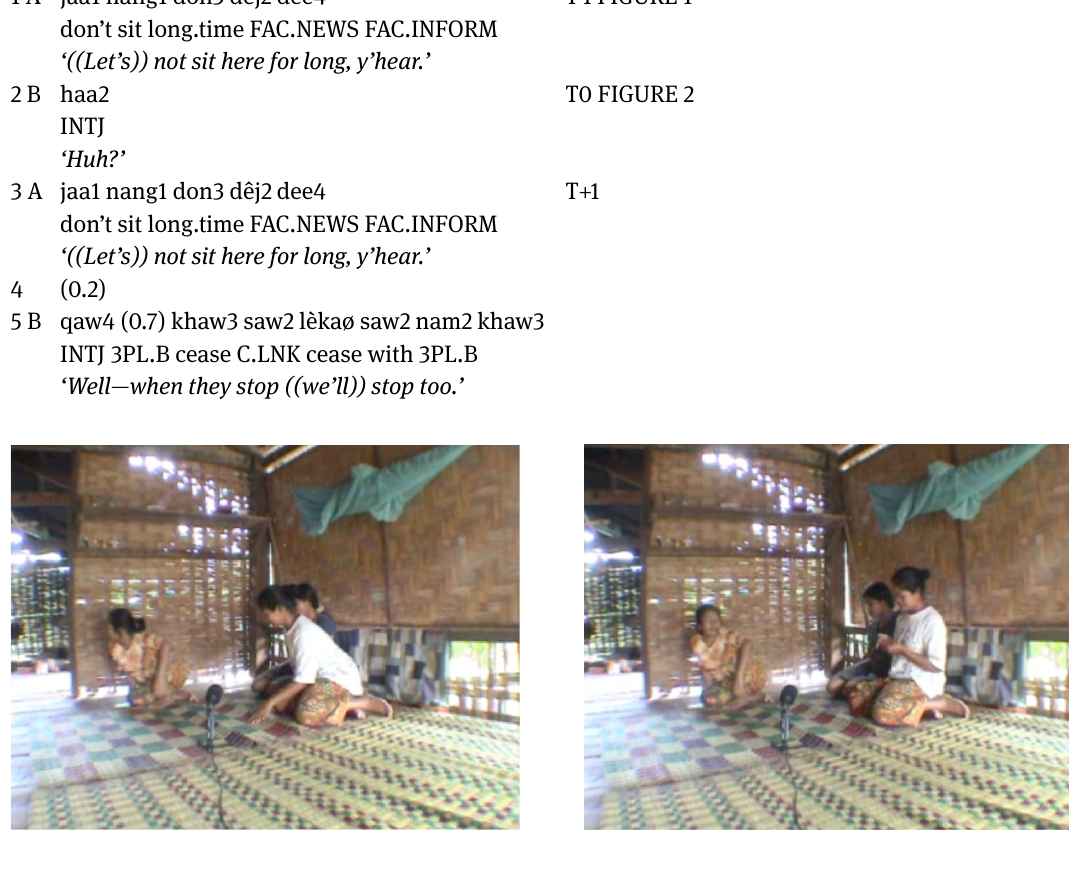
Figure 1: (= line 1 of Extract 3). Figure 2: (= line 2 of Extract